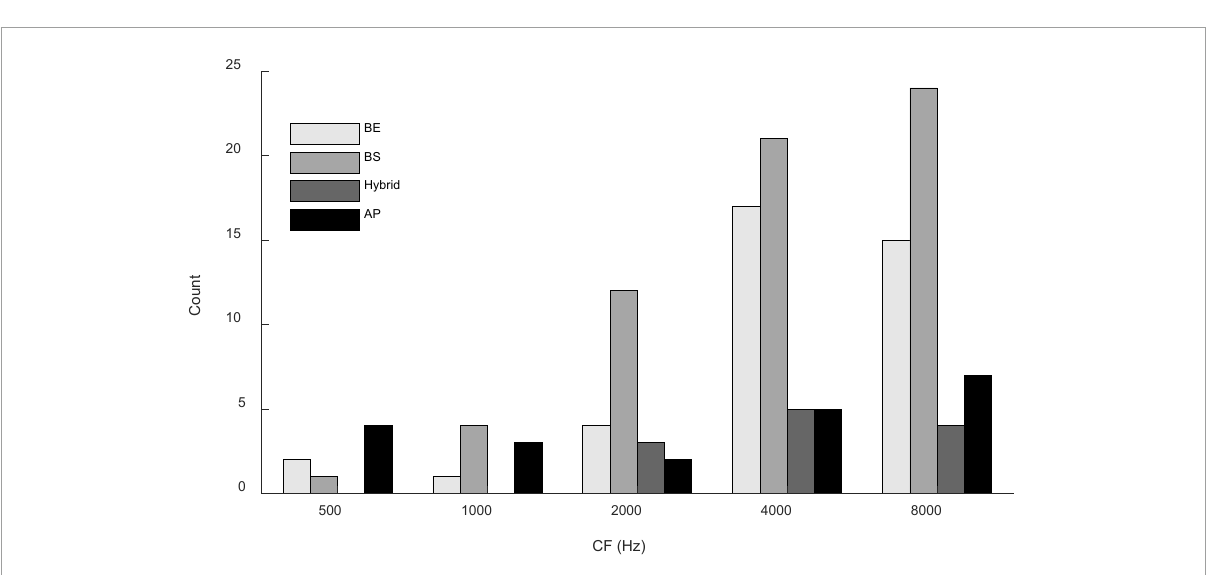
FIGURE2 Distribution of MTFs across CF (in one-octave bins) for the units presented in this study. Gray shades from light to dark indicate units with band-enhanced (BE), band-suppressed (BS), hybrid and all-pass (AP) MTF shapes. Two neurons with CF of 12.1k were included in the last bin for simplicity. Most MTF types were represented across the range of CFs, although hybrid MTFs were not observed at the lower